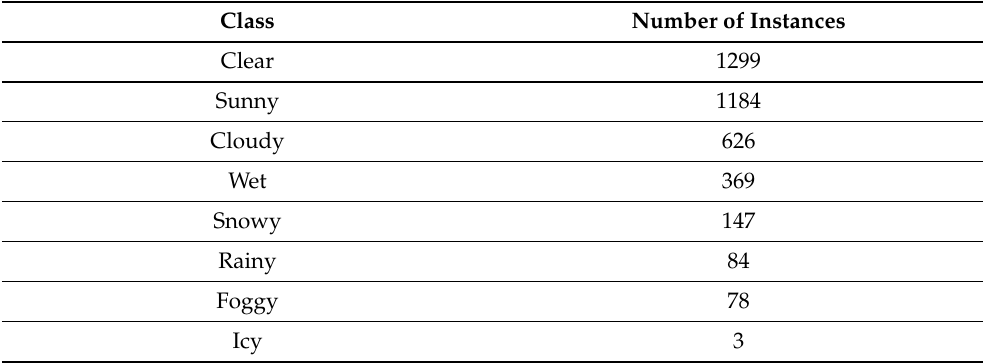
Figure 5. Six samples of weather images from our multi-label road weather dataset. Table 2. Class distribution of the proposed road weather